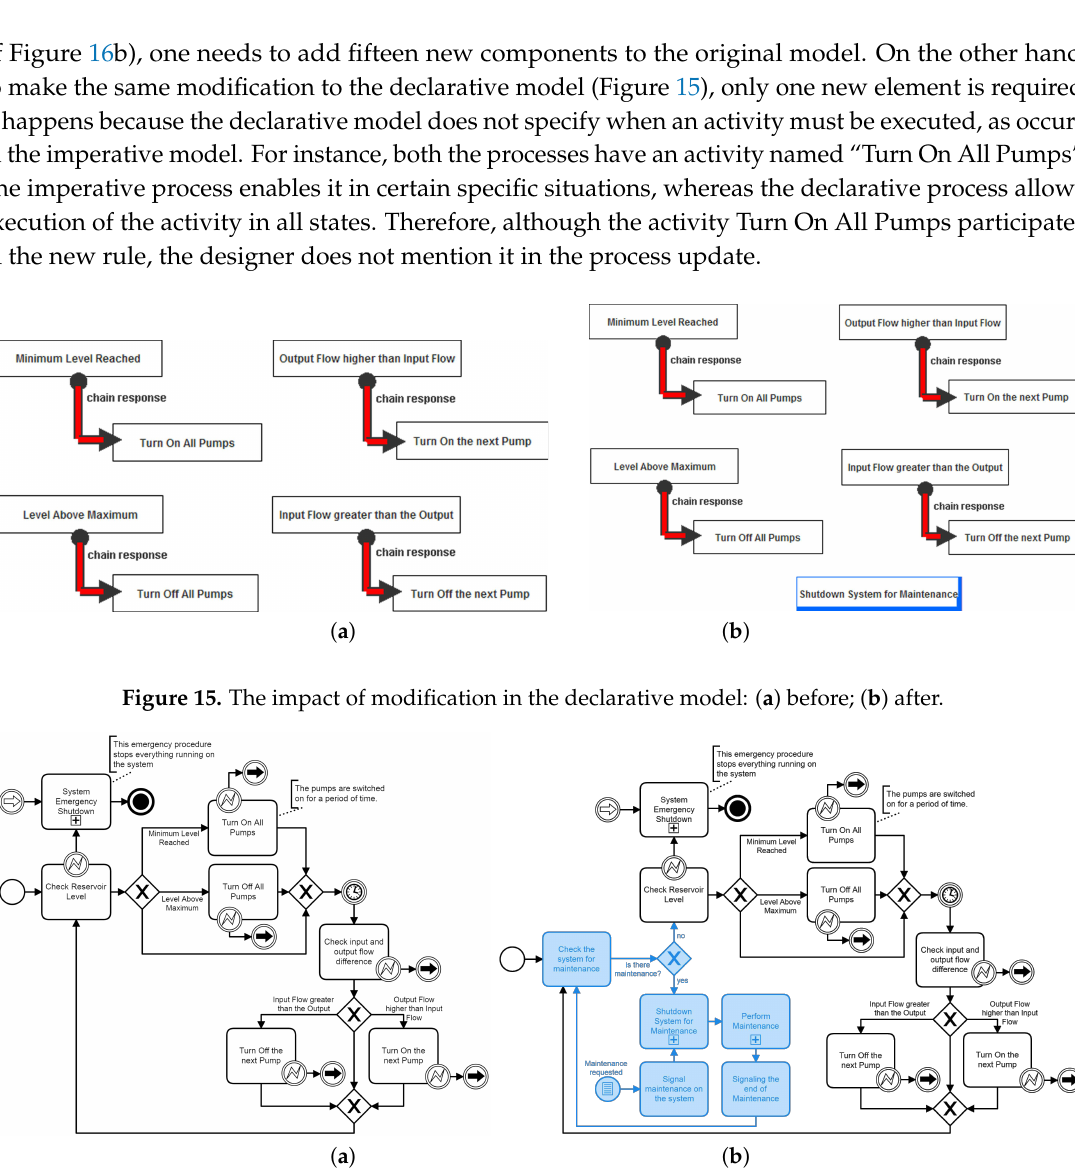
Figure 16. The impact of modification in the imperative model: ( a ) before; ( b )